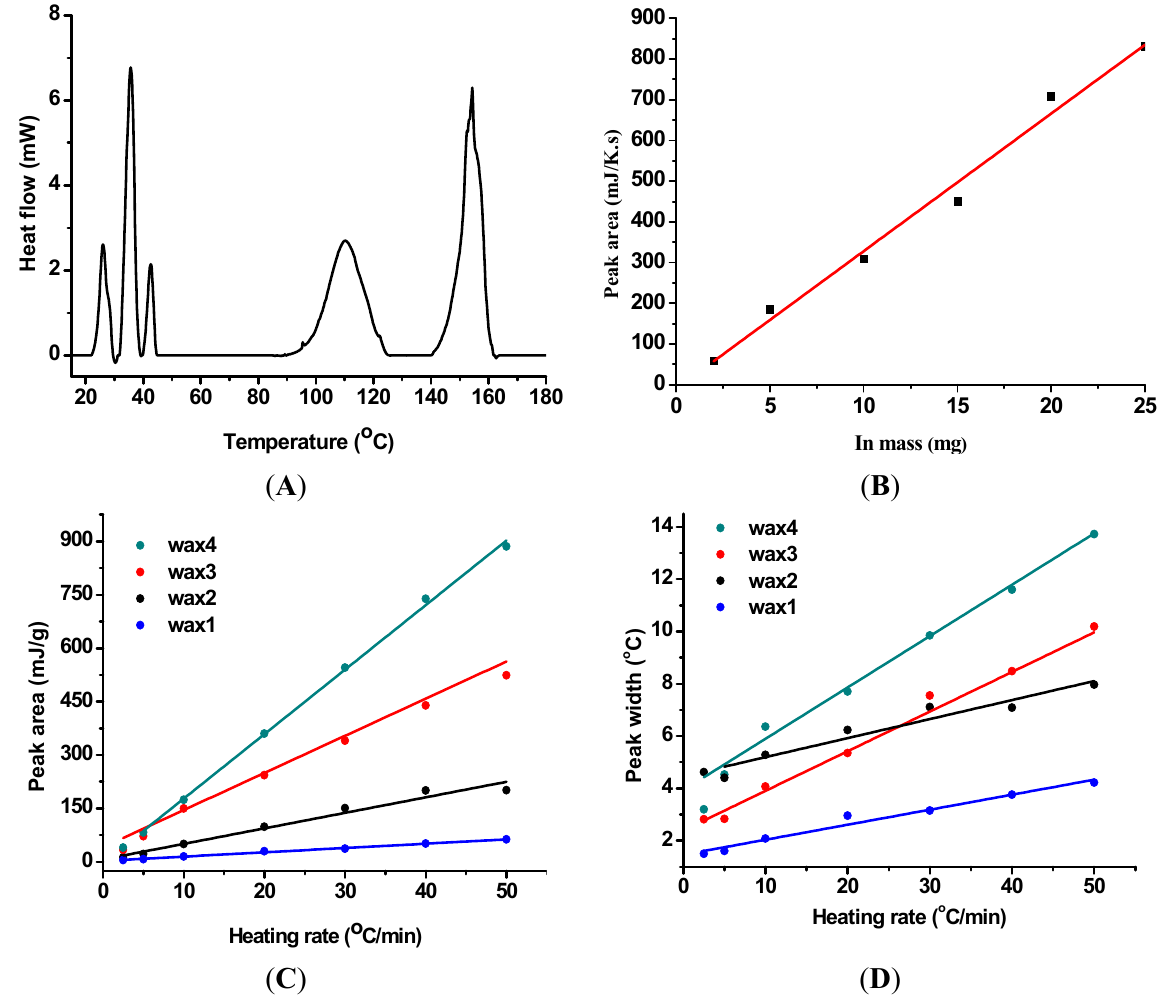
Figure 3. Differential scanning calorimetry (DSC) curve of four paraffin nanoparticles in paclobutrazol ( A ); mass dependent peak area of paraffin nanoparticles ( B ); peak areas ( C ) and peak widths ( D ) of paraffin nanoparticles at different heating